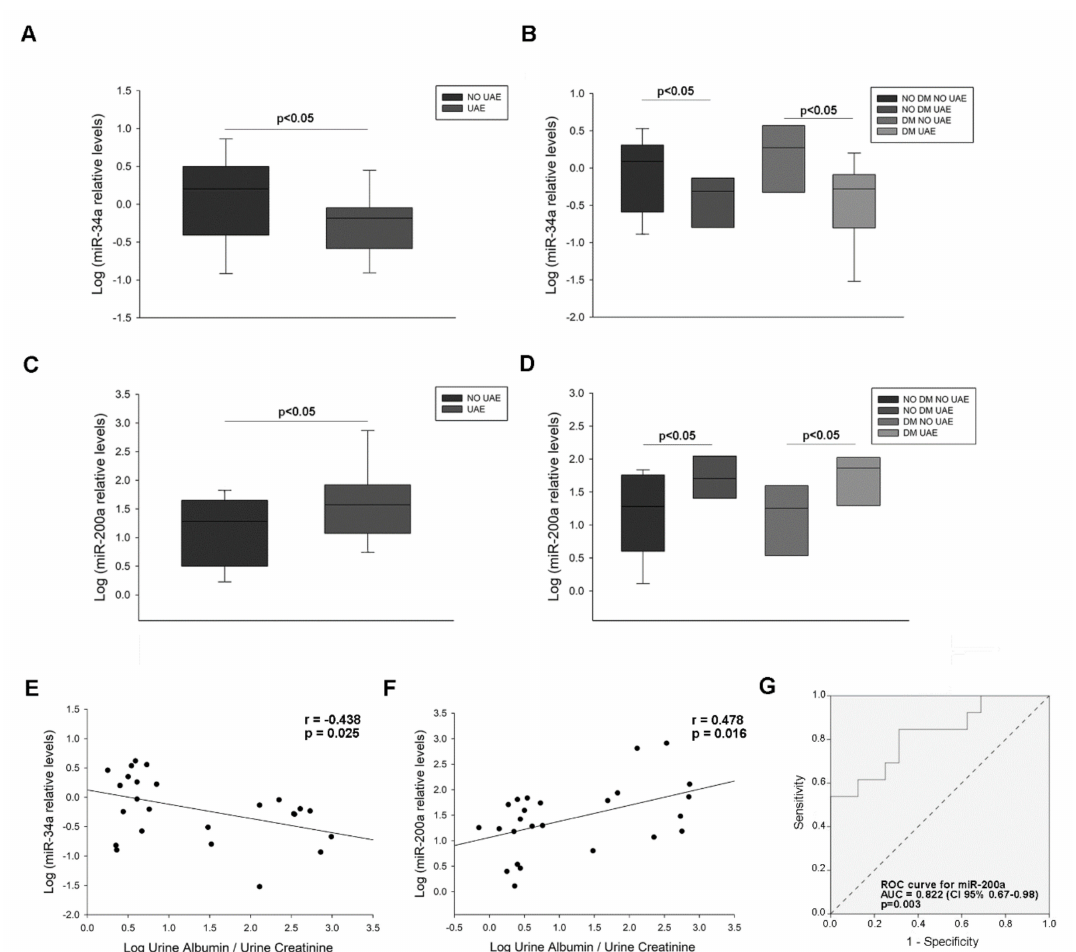
Figure 3. miRNAs levels in urinary sediment of hypertensive patients. ( A ) Box plot of the comparison of miR-34a levels between patients with increased UAE and normal UAE levels; ( B ) Box plot comparing miR-34a levels in patients with hypertension and normal UAE (NO DM NO UAE) with non-diabetic patients with increased UAE (NO DM UAE), diabetic patients with normal UAE (DM NO UAE) and diabetic patients with elevated UAE (DM UAE); ( C ) Box plot of the comparison of miR-200a levels between 2 groups (above described); ( D ) Box plot comparing miR-200a levels between patients divided in 4 groups (above described); ( E ) Scatter plot of the correlation between miR-34a levels and UAE values; ( F ) Scatter plot of the correlation between miR-200a levels and UAE values; ( G ) ROC curve analysis of miR-200a to test its predictive value for UAE discrimination. Horizontal bars represent median ± SEM. miRNA levels were normalised to two housekeeping miRNAs and log relative expression was expressed: a miRNA is up-regulated when its relative values are higher in the disease group than those in controls. If the values are lower, the miRNA is down-regulated. The AUC and 95% CI are plotted in the graph. UAE: urinary albumin excretion; DM: diabetes mellitus; ROC: Receiver operating characteristic; AUC: area under the curve; CI: confidence